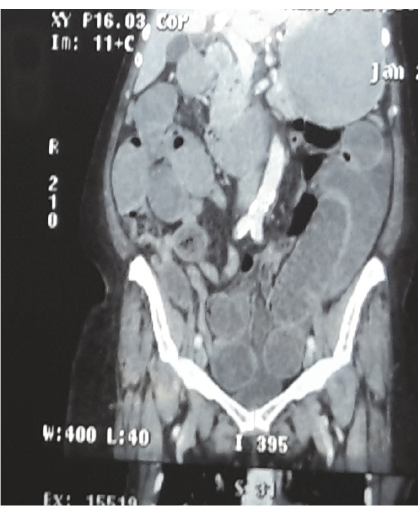
Figure 1: Coronal view of the computed tomography (CT) of the abdomen showing grossly dilated thickened small bowel loops up to the region of right iliac fossa.